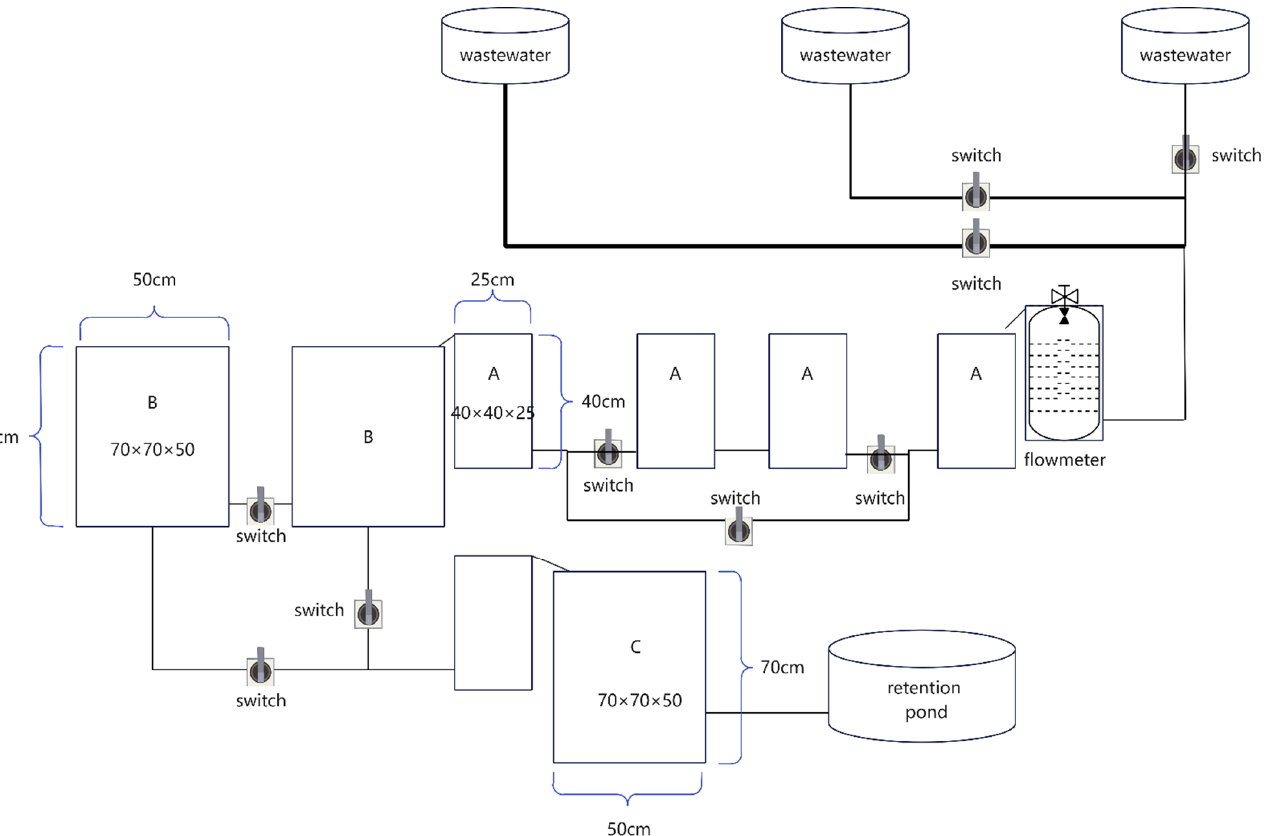
Figure 1. The self-designed wastewater circulation device.